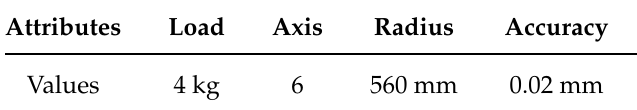
Table 2. Robot performance parameters.